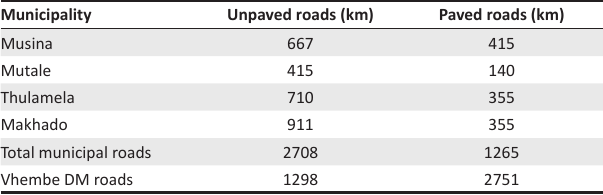
TABLE 3: Lengths of roads earmarked for maintenance per municipality in 2013. Municipality